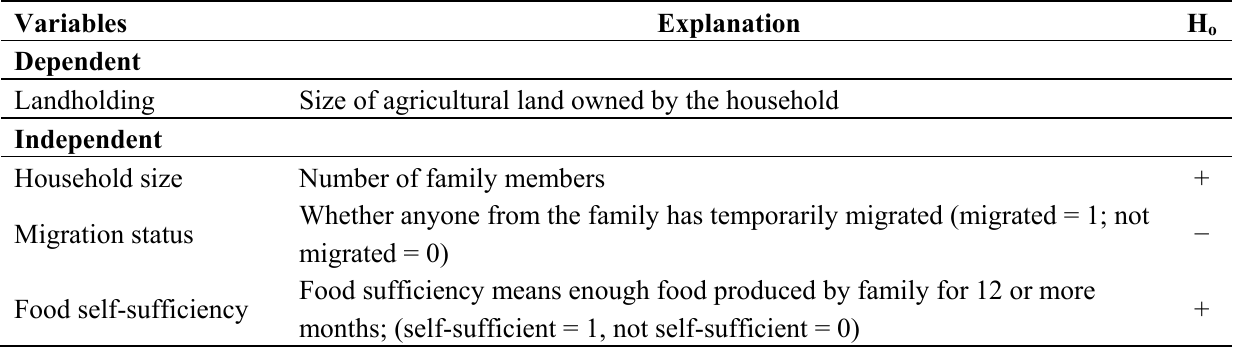
Table 1. Definitions of explanatory (independent) and response (dependent)